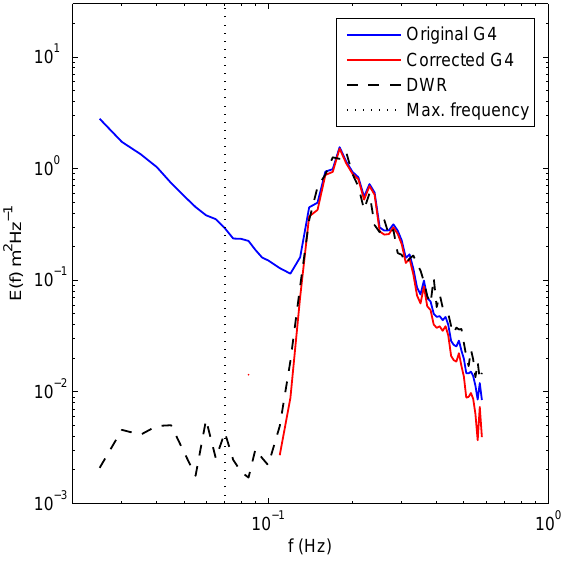
Figure 9. The example spectra from Fig. 7d shown on a logarithmic scale for illustrative purposes. Note that the values that are in set to zero in the corrected spectra cannot be displayed on the logarithmic